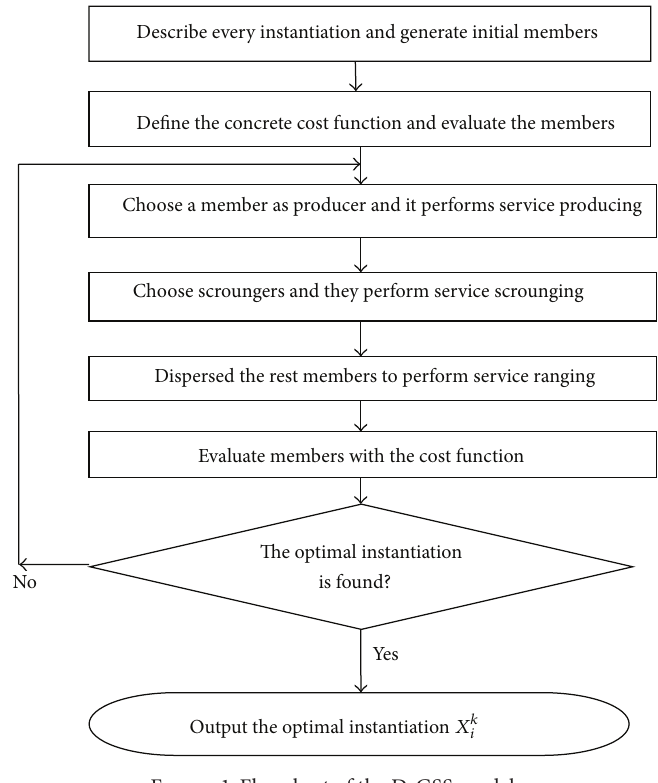
Figure 1: Flowchart of the D-GSS model. Table 1: Aggregated methods for global QoS